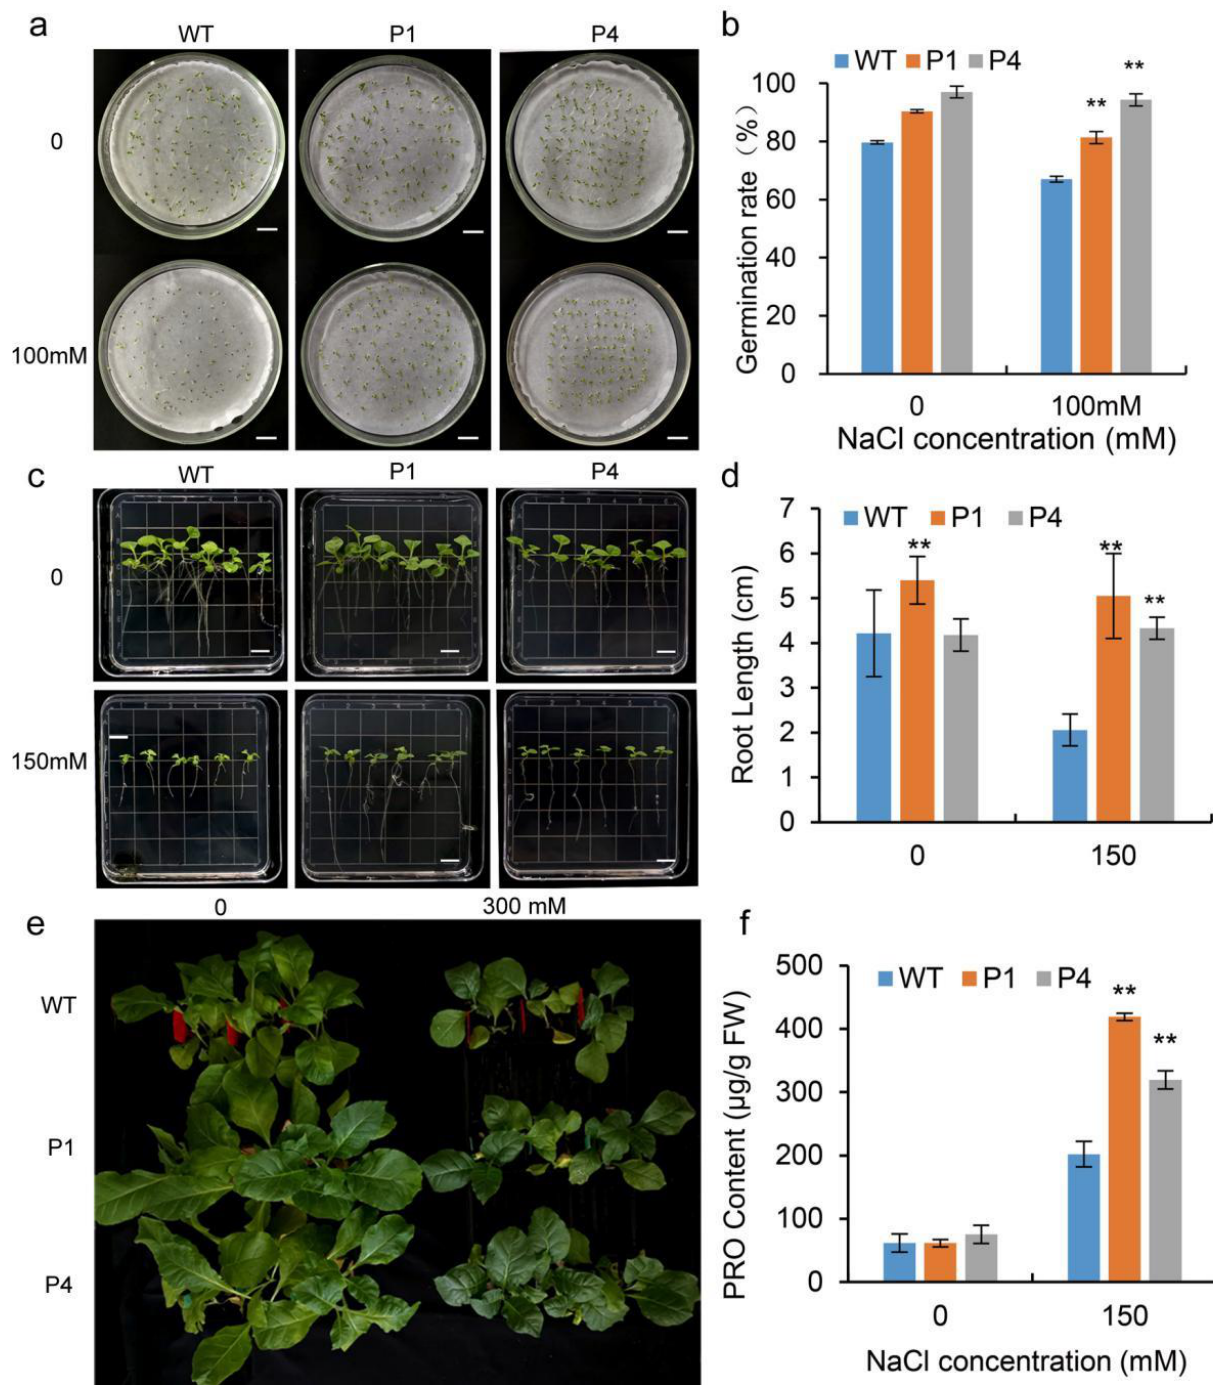
Figure 6. Seed germination and growth of wild-type (WT) and EuPIP1;2-overexpressing tobacco lines (P1 and P4) treated with NaCl. ( a ) Germination of seeds (bar = 1 cm) and ( b ) percentage germination of seeds treated with 0 or 100 mM NaCl. ( c ) Growth of seedlings (bar = 1 cm) and ( d ) root length of seedlings treated with 0 or 150 mM NaCl. ( e ) Phenotypes of WT and transgenic lines treated with 0 or 300 mM NaCL. ( f ) Proline (PRO) content in the leaf of seedlings treated with 0 or 150 mM NaCl. Data were analyzed statistically using SPSS. **P < 0.01.